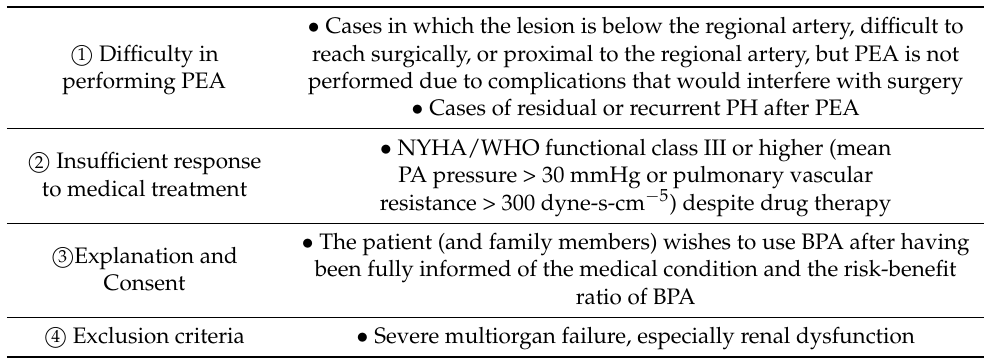
Table 5. Indications for